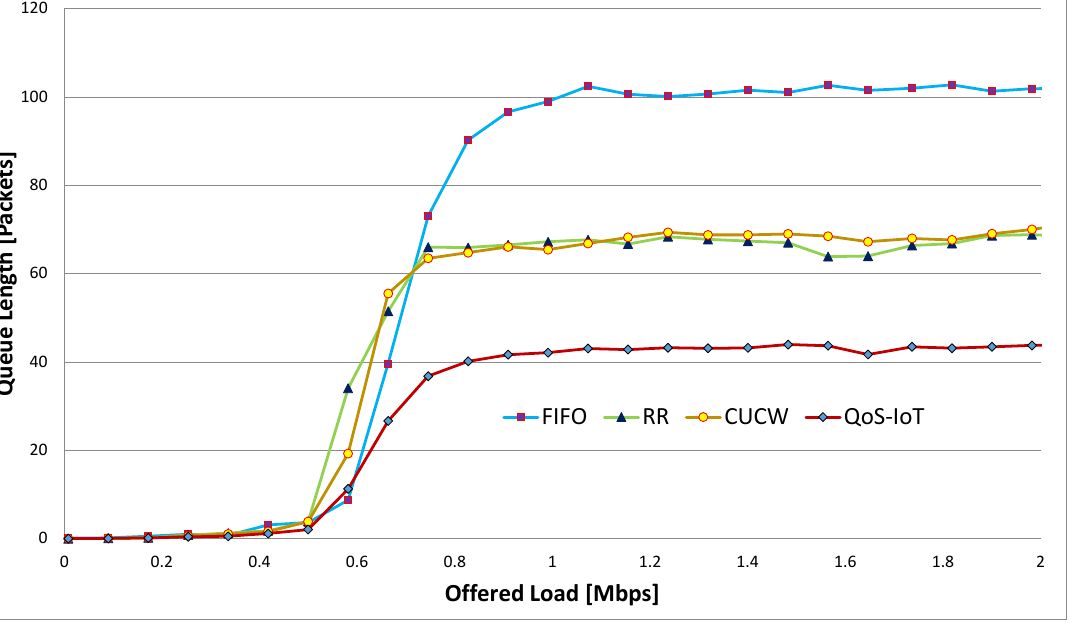
Figure 7. Average queue length in of all